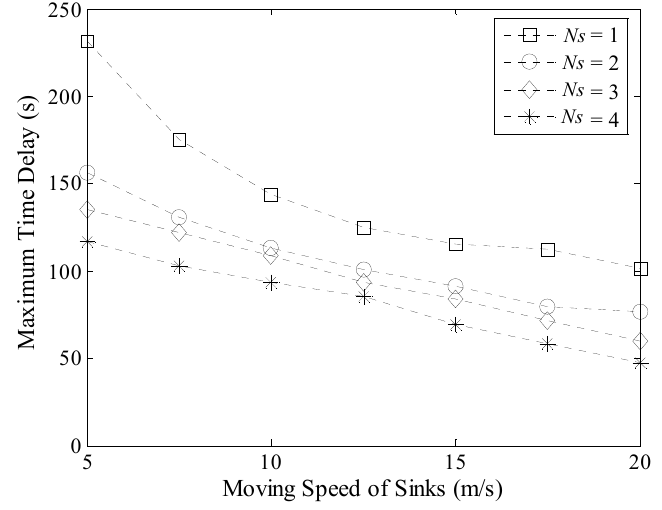
Figure 24. Maximum time delay with different moving speeds of Sinks.